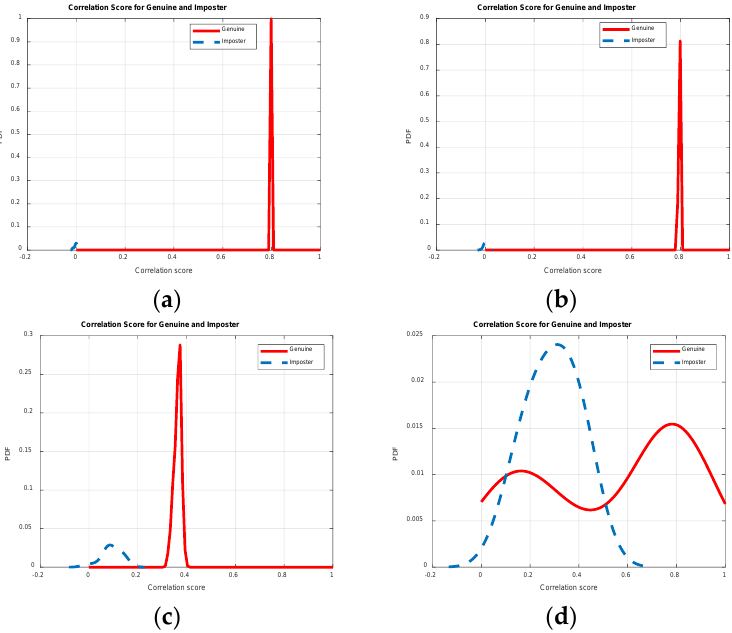
Figure 28. Probability distributions for cancellable face recognition frameworks (for LFW dataset) for ( a ) CFR1, ( b ) CFR2, ( c ) homomorphic transform followed by salting and ( d ) homomorphic transform followed by random kernel convolution.